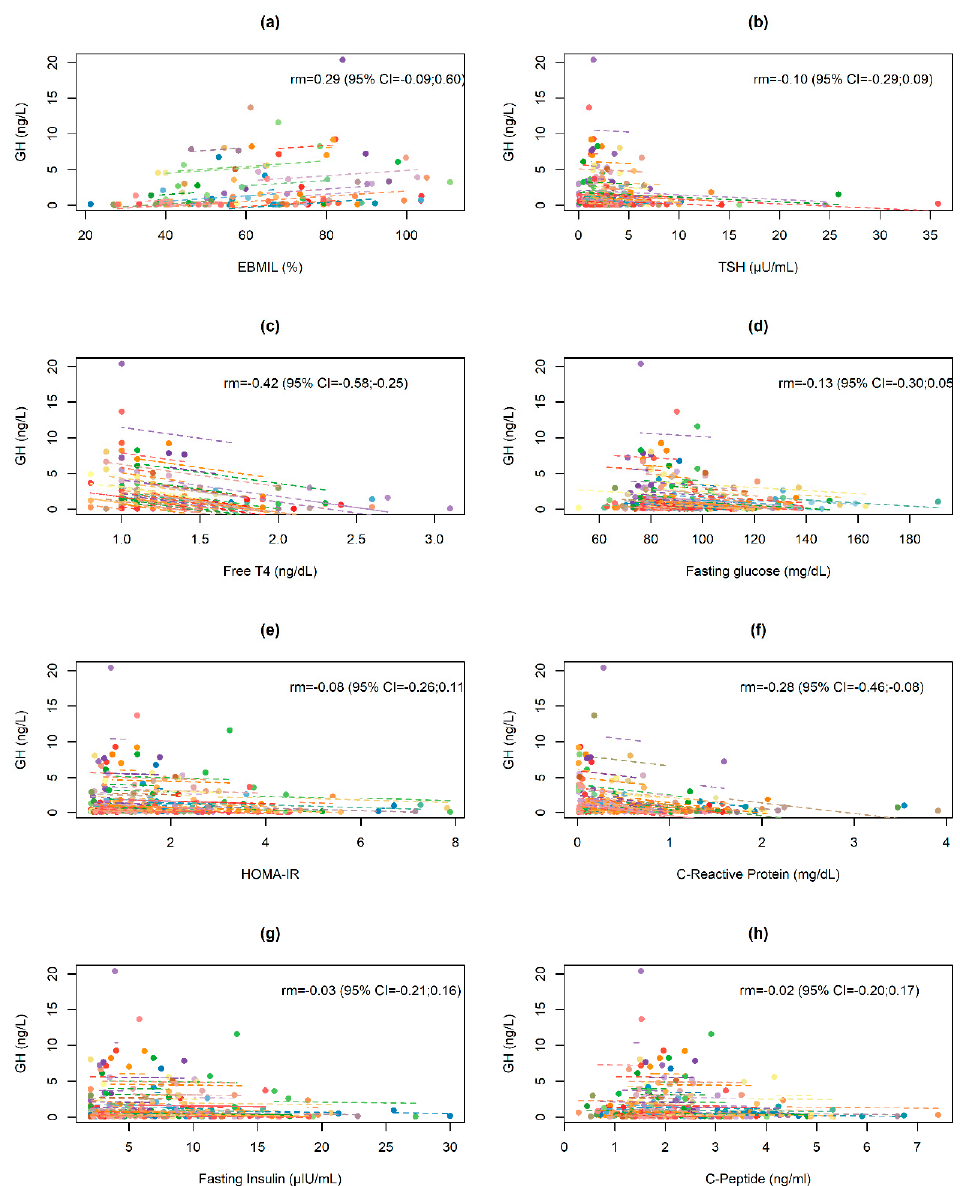
Figure 4. Repeated measures correlation for the overall relationship between changes in GH and ( a ) EBMIL, ( b ) TSH, ( c ) free T4, ( d ) fasting glucose, ( e ) HOMA-IR, ( f ) C-reactive protein, ( g ) fasting insulin and ( h ) C-peptide. Obese subjects are represented by points that correspond to pre- and post-operative IGF-1 levels and the respective anthropometric, biochemical and hormonal data. Each line represents the correlation adjustment of repeated measures for each participant.